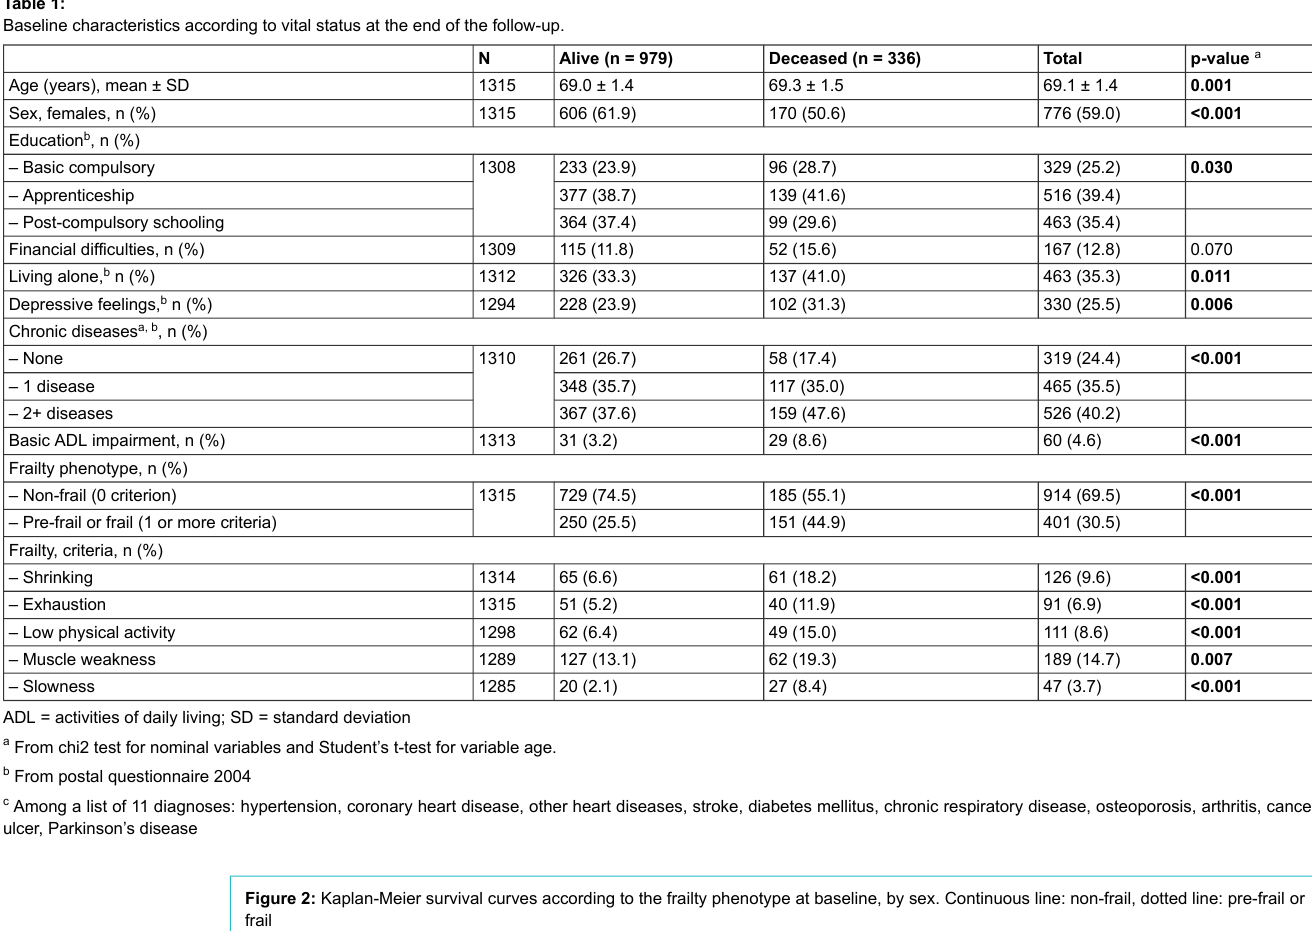
Table 1: Baseline characteristics according to vital status at the end of the follow-up.